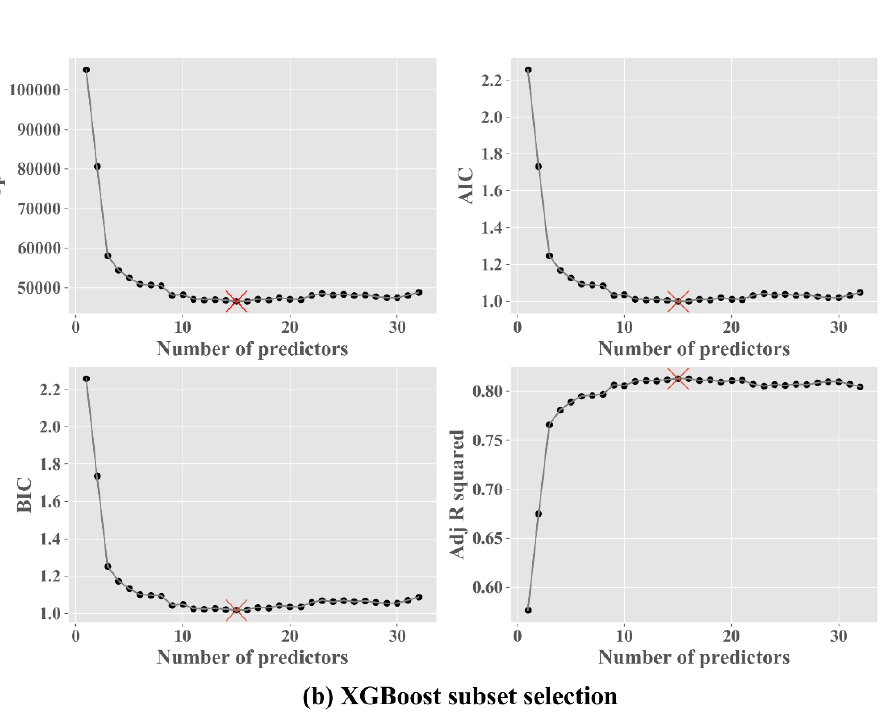
Figure 7. Forward stepwise subset selection using C p , AIC, BIC and adjusted R 2 .